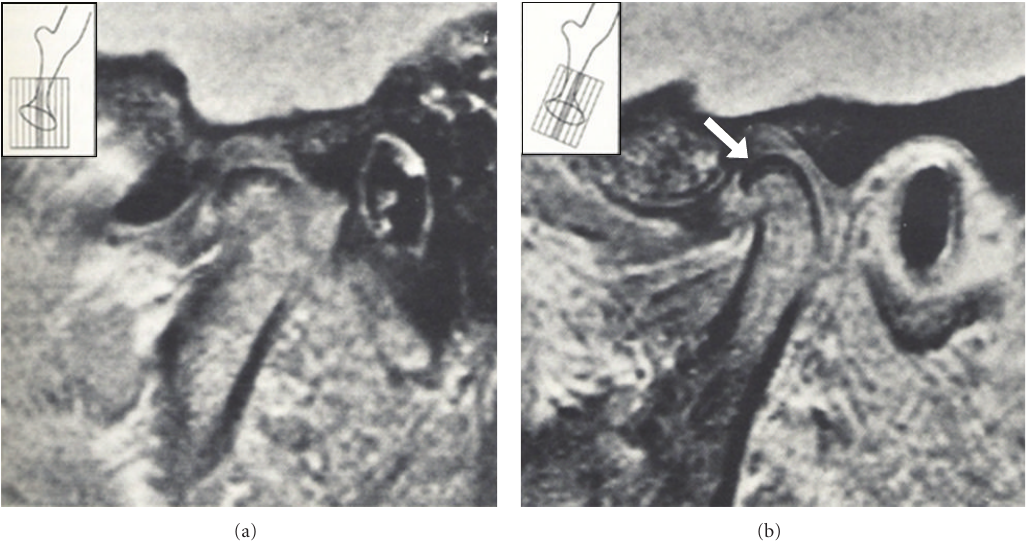
Figure 1: MRI images of the TMJ in the sagittal plane. MRI images in the central part of two joints, highlighting the sagittal versus the angulated planes. The image on the left shows the standard sagittal plane, and the posterior band of the disc is not visible. The image on the right shows the angulated plane of the same joint, and the posterior band is visible as indicated by the arrow. The insets in both images diagram the scanning planes